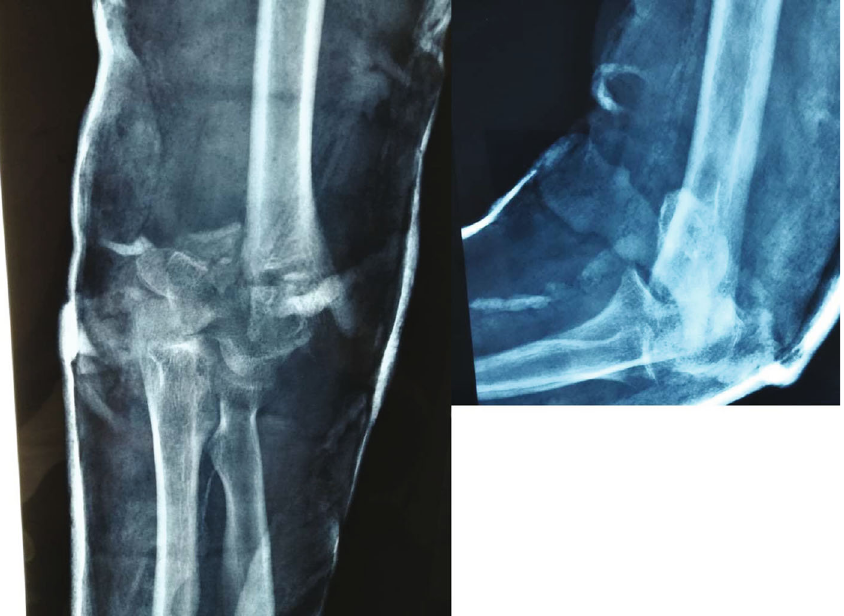
Figure 1: Distal humerus fracture malunion. Anteroposterior and lateral